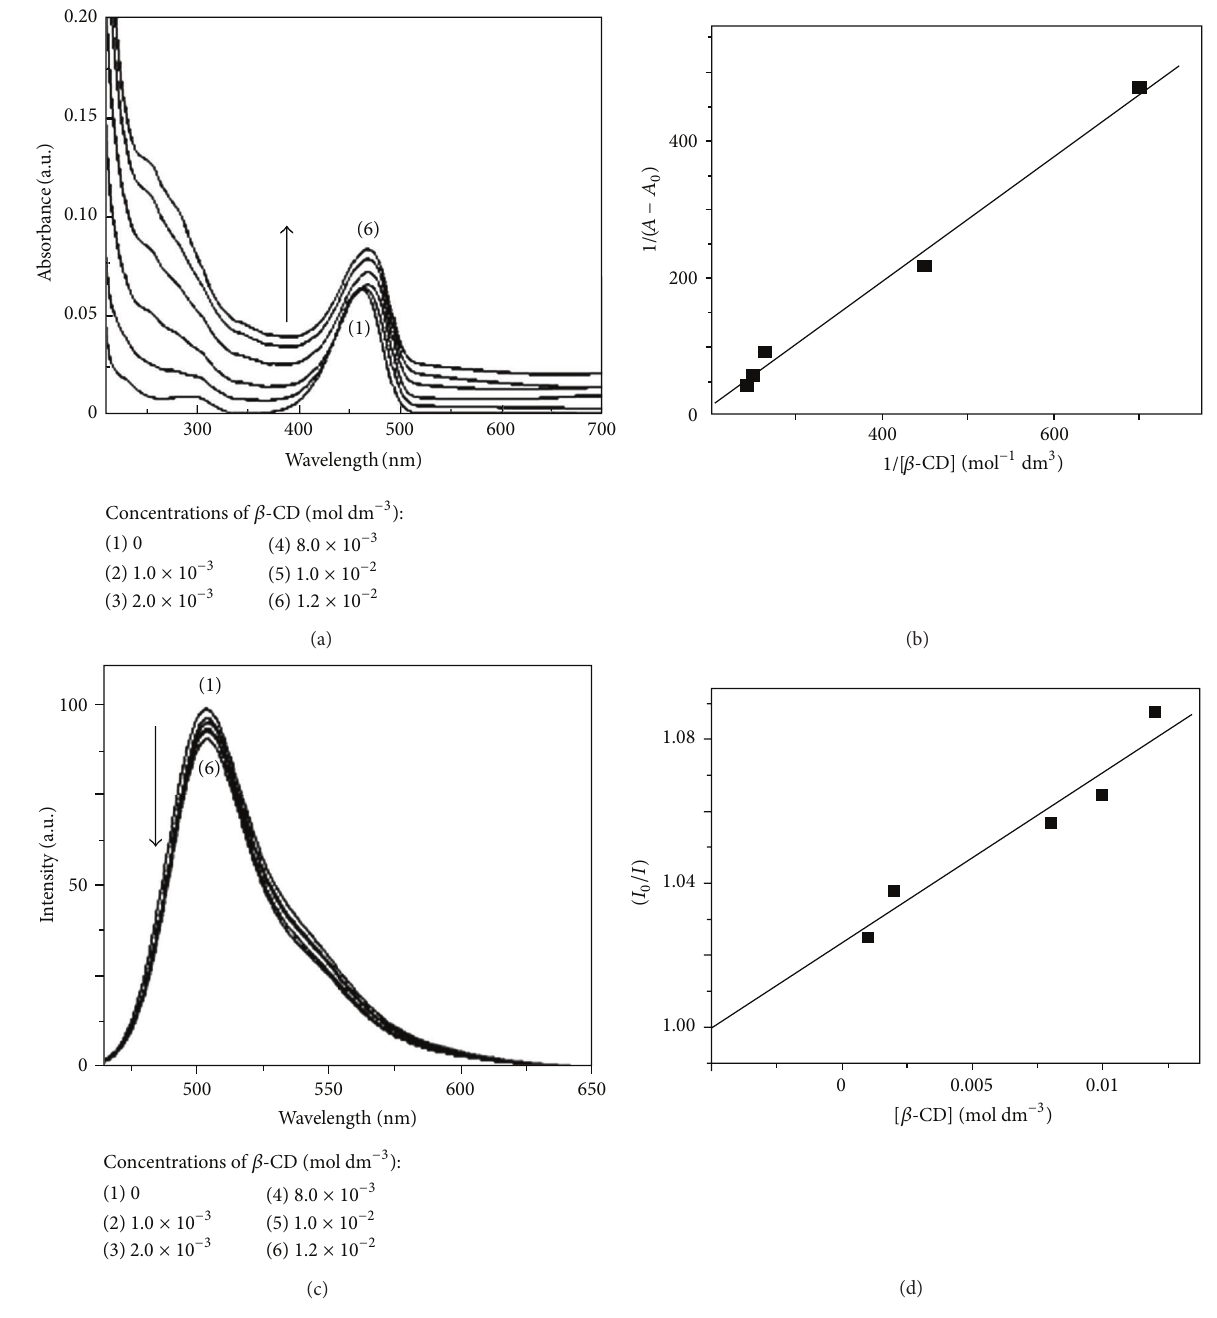
Figure 2: (a) Absorbance spectra of C334 with varying concentrations of 𝛽 -CD. (b) 1/ (𝐴−𝐴 0 ) versus 1/[ 𝛽 -CD] plot of C334- 𝛽 -CD complex. (c) Fluorescence spectra of C334 with varying concentrations of 𝛽 -CD. (d) Stern-Volmer plot of C334- 𝛽 -CD complex. Table 2: Time-resolved fluorescence spectral data of C334 in water and in 𝛽